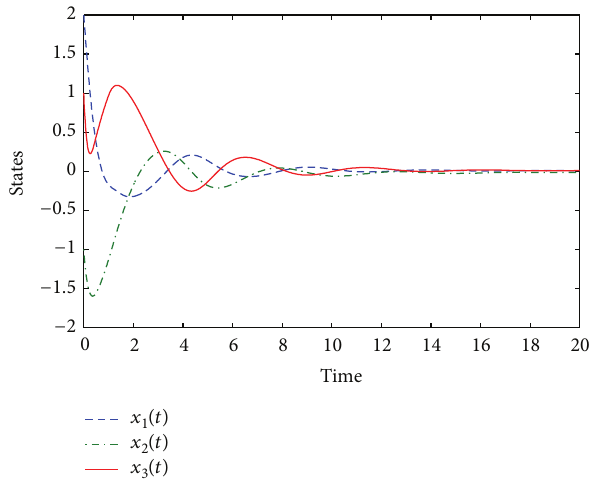
Figure 3: Time response of the state variables with fractional order 𝛼 = 0.90 .